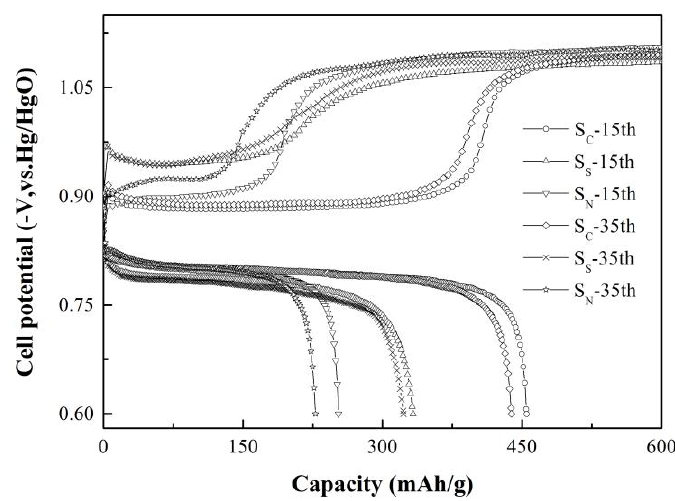
Figure 3. Potential-capacity curves of Co-B alloy anodes at the 15th and 35th cycles.